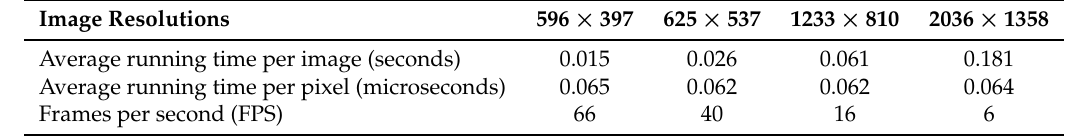
Table 4. Comparison of the average running time (seconds) on four sets of iris images with different